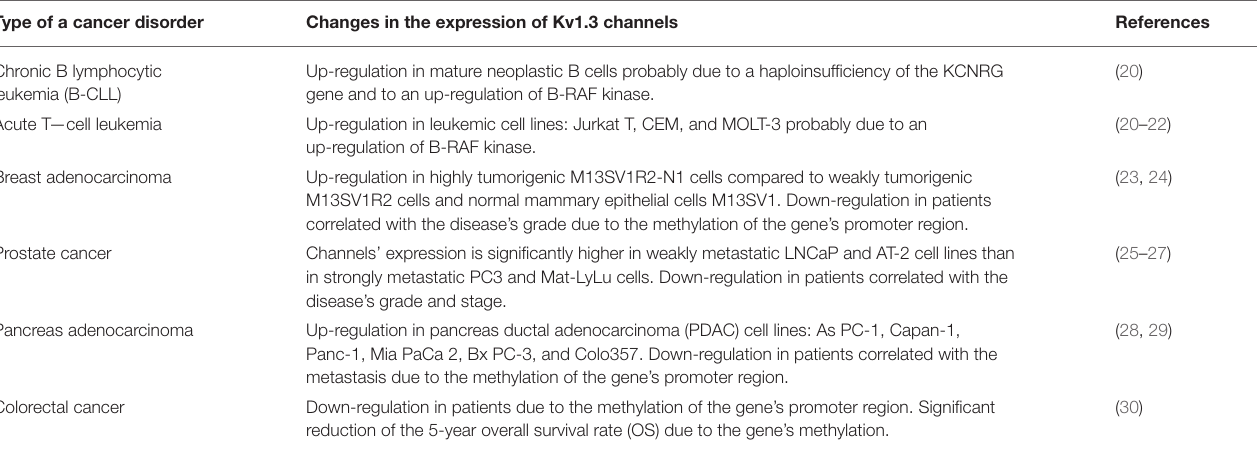
TABLE 1 | Changes in the expression of Kv1.3 channels in selected cancer